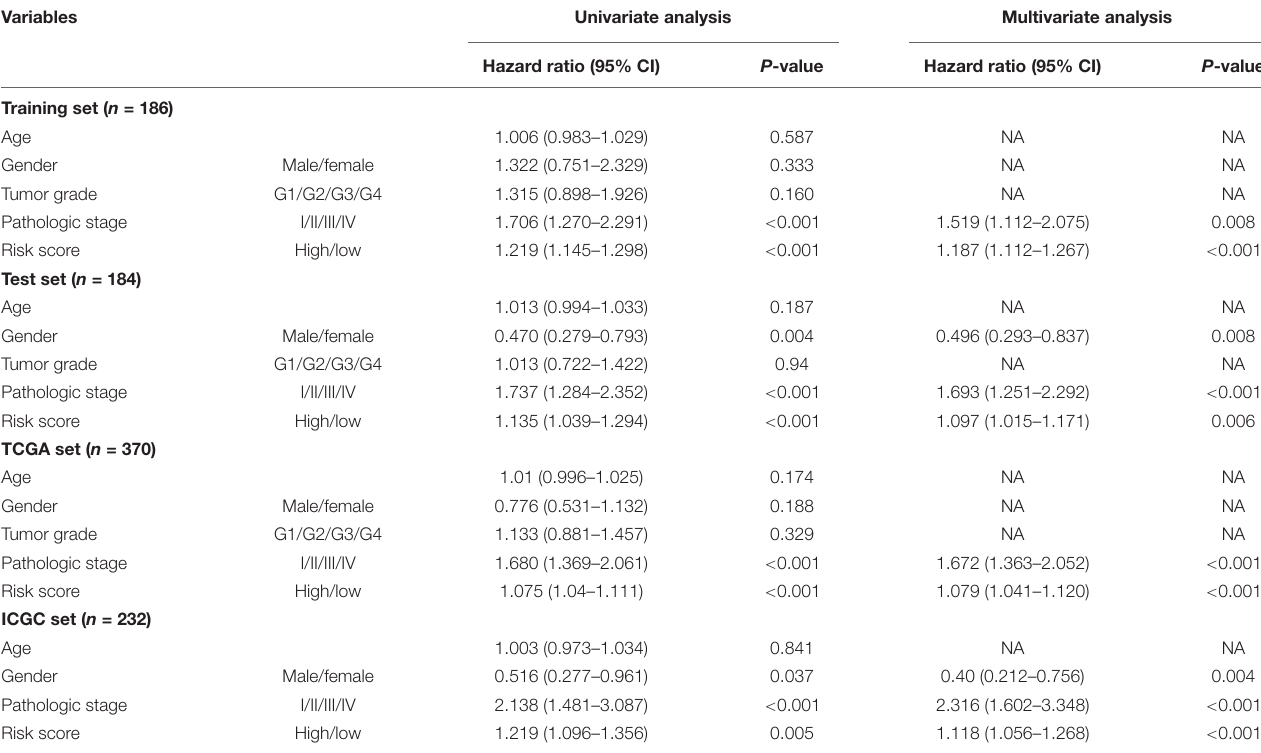
FIGURE 3 | Evaluation and validation of the predictive values of GIGSig. Kaplan–Meier analysis of OS of patients in high- and low-risk groups predicted by the GIGSig in the training set (A) , test set (B) , TCGA set (C) , and ICGC set (D) . ROC curve analysis of the GIGSig of the training set (E) , test set (F) , TCGA set (G) , and ICGC set (H) . TABLE 3 | Univariate and multivariate cox regression analysis of the GIGSig and clinicopathologic factors in different patient